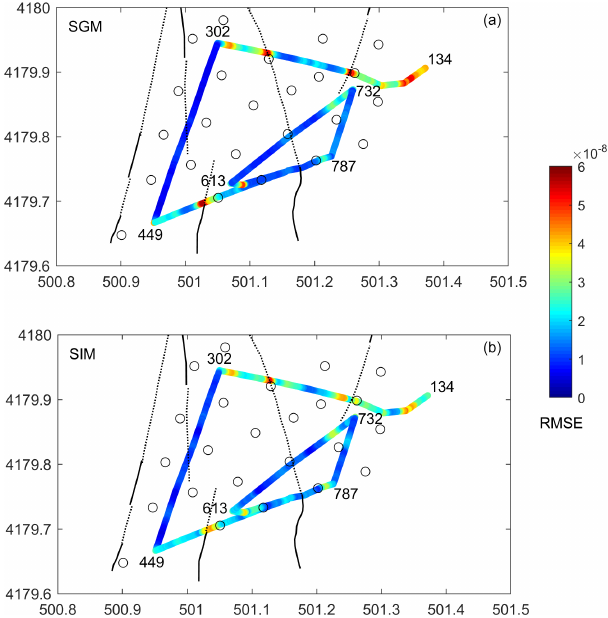
Figure 4. RMSE residuals between DAS strain measurements (Fig. 2c) and the strain derived from the seismic array along the fibre for the LP event. Black lines and open circles indicate faults and seismometers shown in Fig. 1,